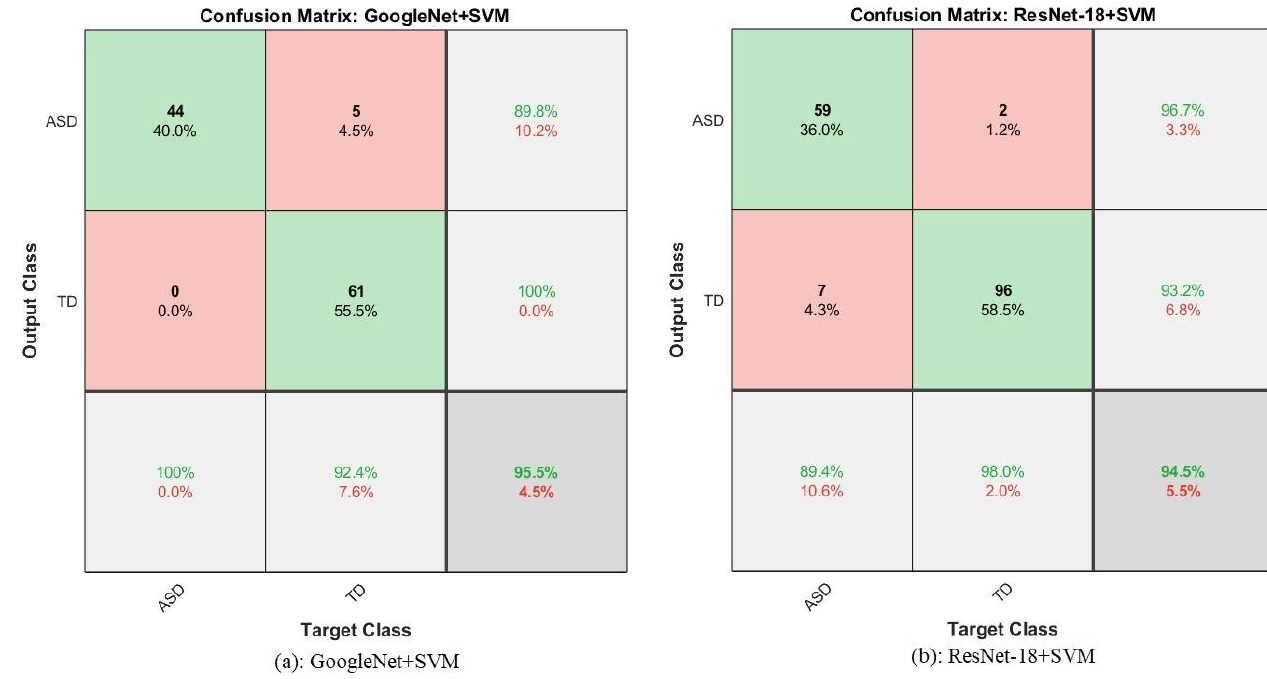
Figure 19. Confusion matrices of ASD dataset. ( a ) GoogleNet + SVM and ( b ) ResNet-18 + SVM.